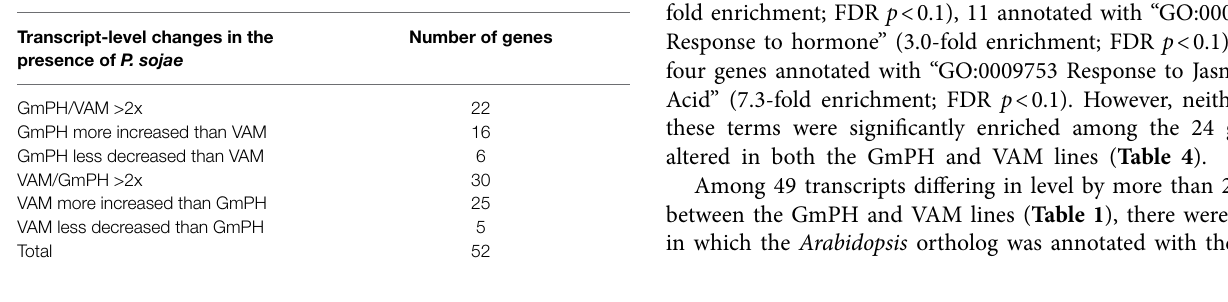
TABLE 4 | Enrichment of Gene Ontology (GO) terms among genes significantly altered in transcript levels in GmPH and VAM lines in the absence of Phytophthora sojae . Gene transcript